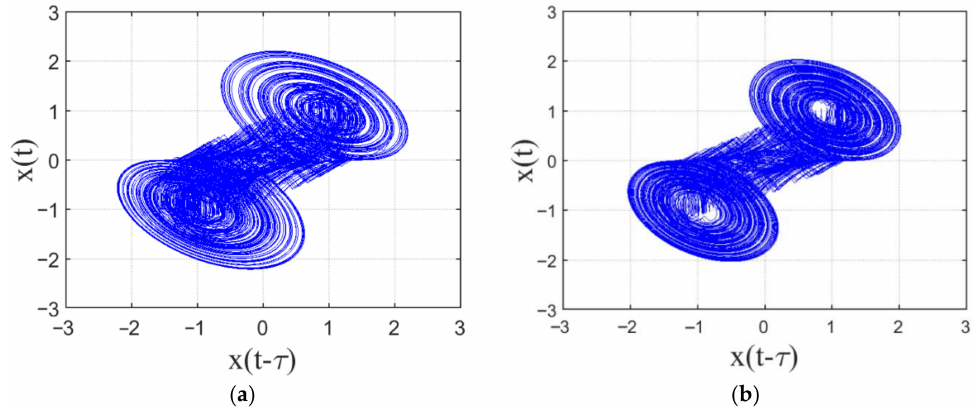
Figure 8. Chaotic attractors for x ( 0 ) = 0.5, τ = 0.6 ms, a = 1, b = 3, and k = 1500. ( a ) Time delay τ = 0.6 ms, ( b ) time delay τ = 0.5